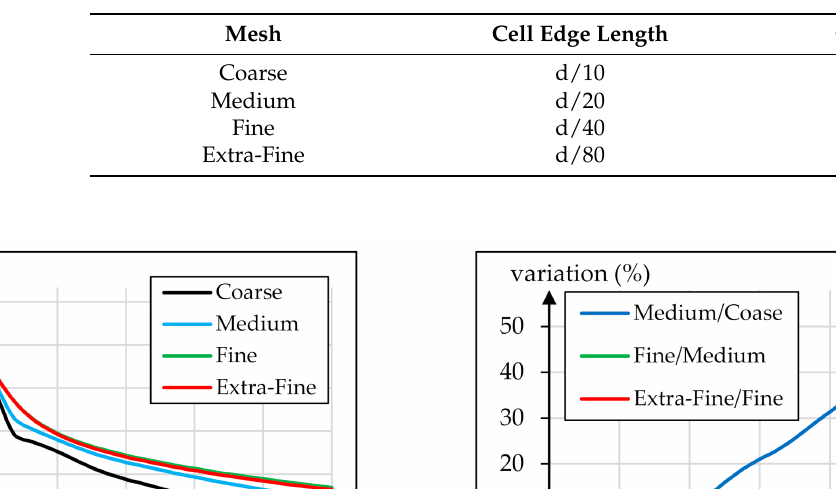
Table 6. Mesh characteristics for the impinging jet test.